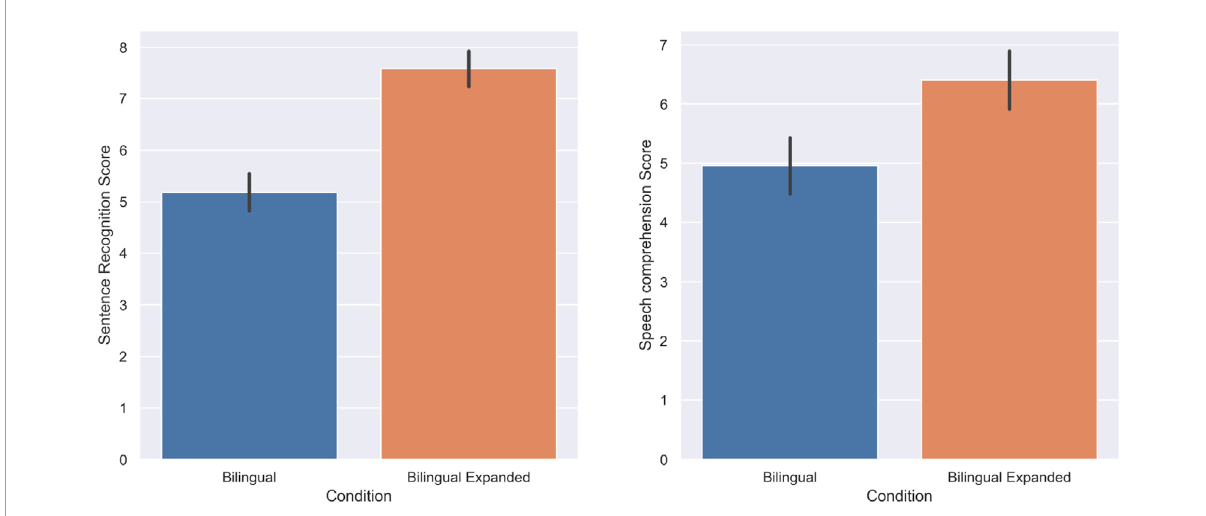
FIGURE 4 Experiment 2: Standard Bilingual and Expanded Bilingual. The score of subjects in the Sentence recognition (A) and Speech comprehension (B) tasks.